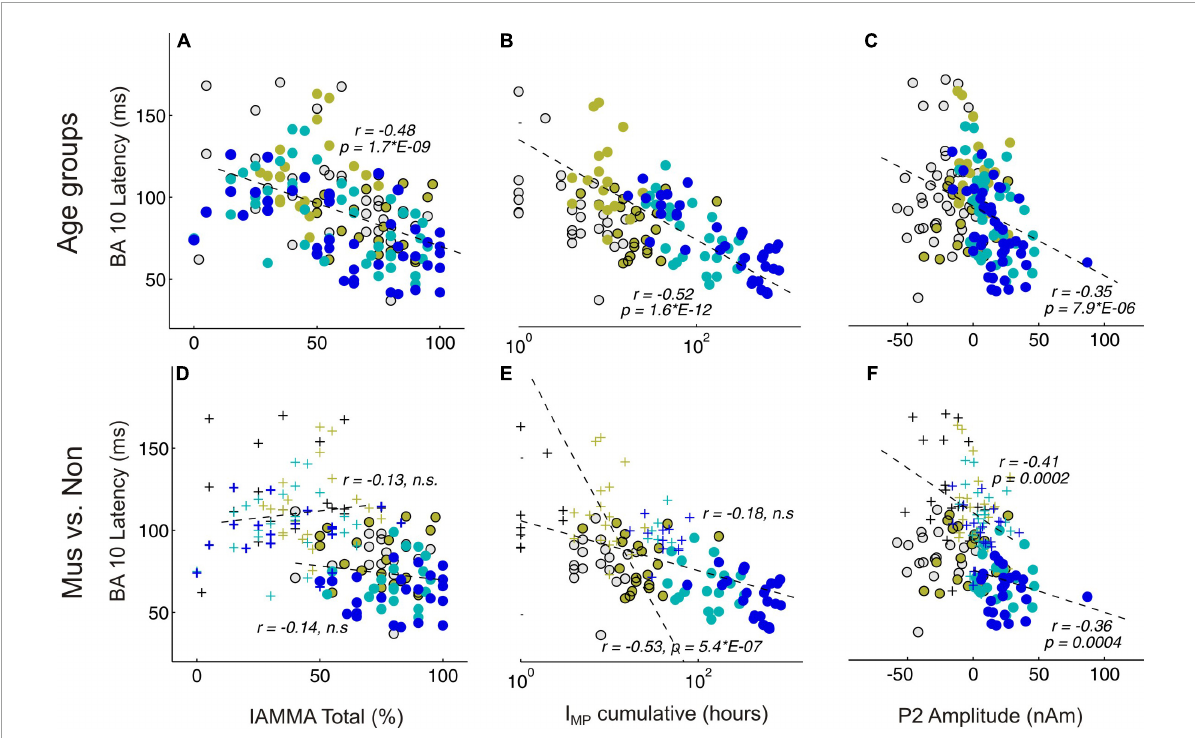
FIGURE5 Correlational analyses between behavioral and MEG variables. (A,D) Represent BA10 latency and AMMA/IMMA score correlations; (B,E) BA10 latency and I MP cumulative; (C,F) BA10 latency and P2 amplitude. (A–C) Depict the correlations over all subjects, colors indicate here the four age groups. (D–F) Depict the correlations separately for the musicians (circles) and the non-musicians (crosses); n.s.,